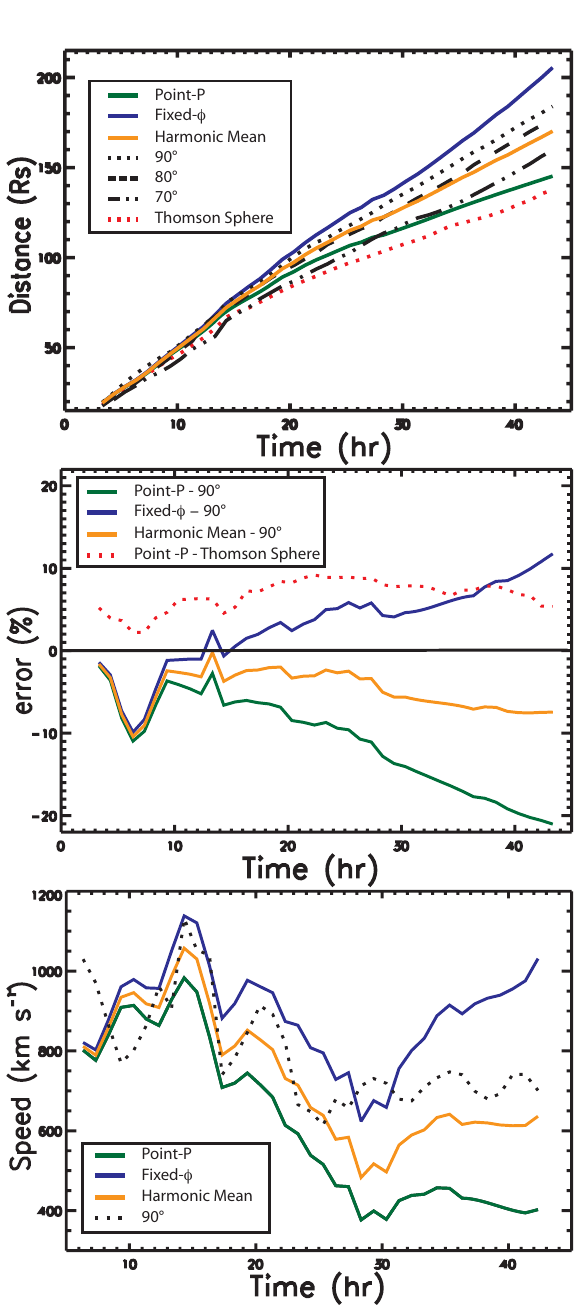
Fig. 2. Position (top), error (center) and speed (bottom) of the sec- ond CME front at PA 90 from the simulation and as derived from the synthetic SECCHI images with the different